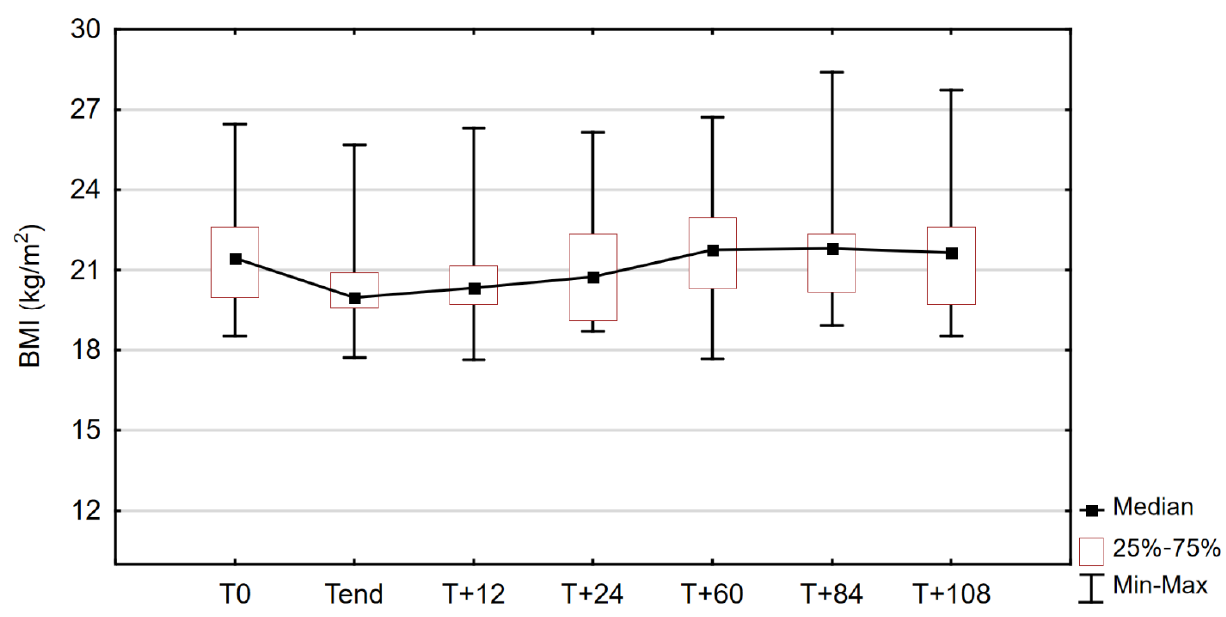
Figure 2. Changes in body mass index (BMI) in the study group throughout the observation period; Friedman test: χ 2 = 23.448, p < 0.001. Friedman test: χ 2 = 23.448, p < 0.001.